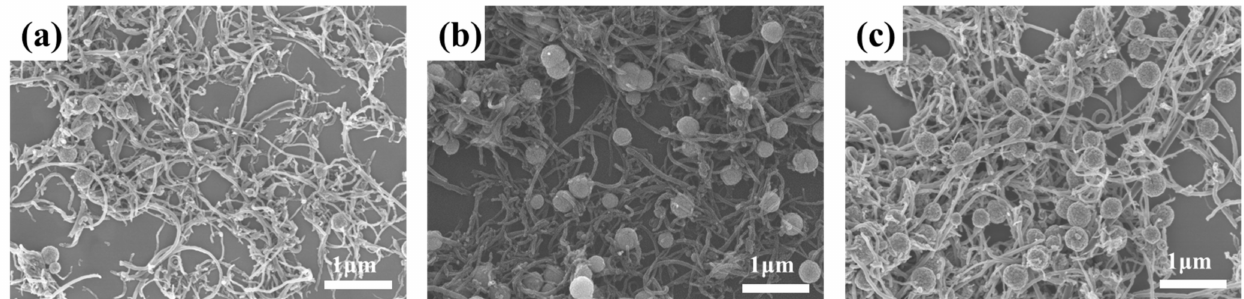
Figure 3. SEM images of Fe 3 O 4 /MWCNT composite with different Fe 3+ : ( a ) 1 mmoL, ( b ) 3 mmoL and ( c ) 5 mmoL.